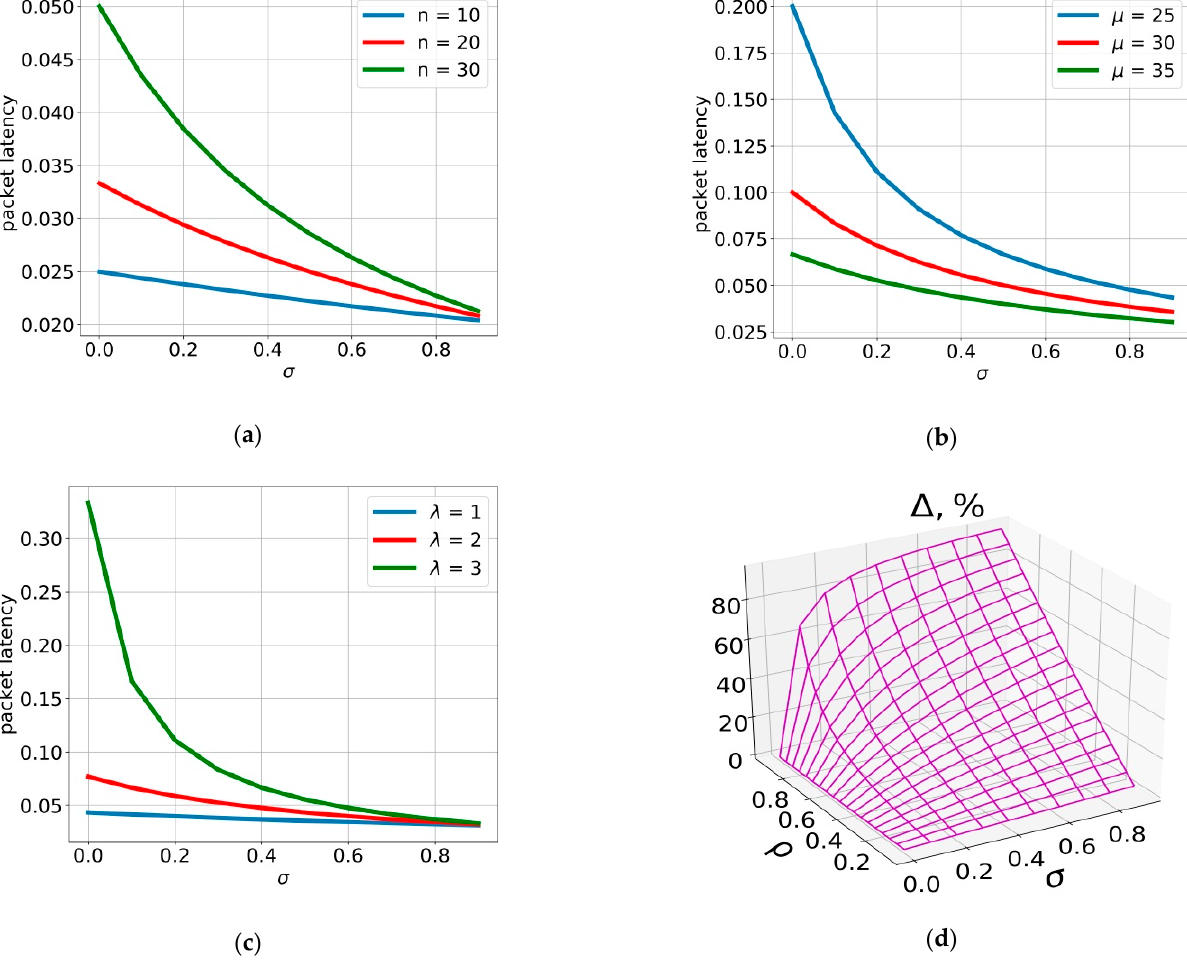
Figure 6. Packet latency versus cluster size reduction: ( a ) the impact of the initial cluster size; ( b ) the impact of cluster head performance; ( c ) the impact of traffic intensity from one cluster node; and ( d ) a 3D plot of the relative difference. At the same time, the number of clusters is positively correlated with the cluster